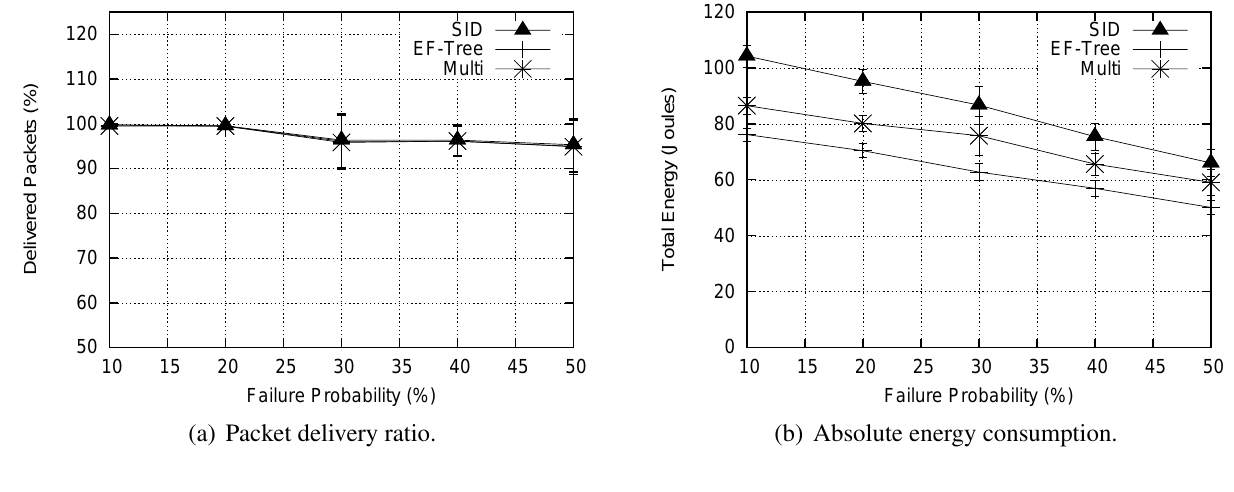
Figure 10. Multi-MAF’s performance under different probabilities of failure.